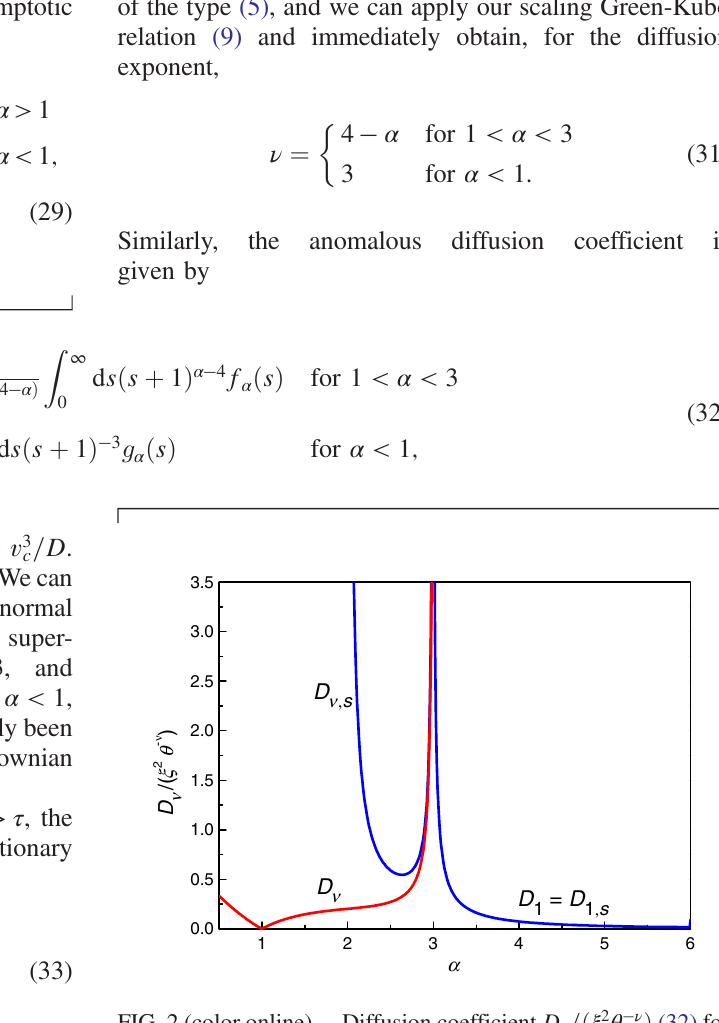
FIG. 2 (color online). Diffusion coefficient D ν = ð ξ 2 θ − ν Þ (32) for cold atoms in optical lattices as a function of the parameter α (red line); the result for the normal diffusive case α > 3 was taken from Ref. [53]. The result D ν from using the stationary ; s correlation function Eq. (34) is shown in blue. The coefficient D ν diverges at the transition from normal to anomalous super- diffusion ( α ¼ 3 ) and vanishes at the transition from super- diffusion to t 3 diffusion ( α ¼ 1 ). While the values obtained from the aging and stationary correlation functions agree if the system is in the normal phase α > 3 , they differ significantly as the system becomes more superdiffusive, clearly signifying the dependence on the initial condition. As α approaches the transition to aging behavior at α ¼ 2 , the stationary correlation function ceases to provide a good description of the finite time system and the corresponding diffusion coefficient